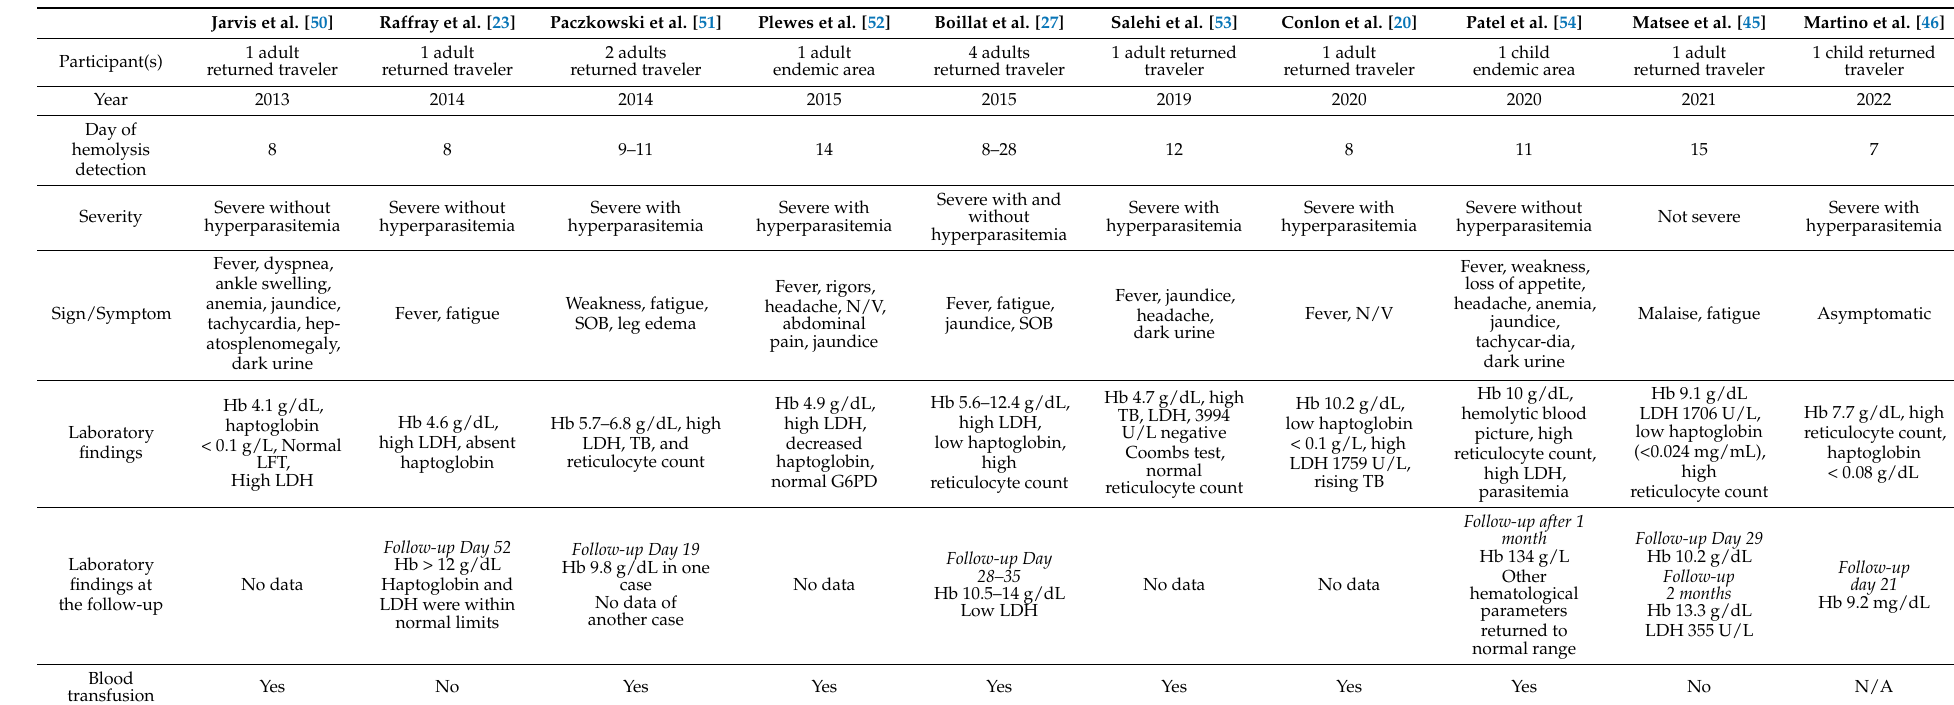
Table 3. Characteristics of PADH patients in case